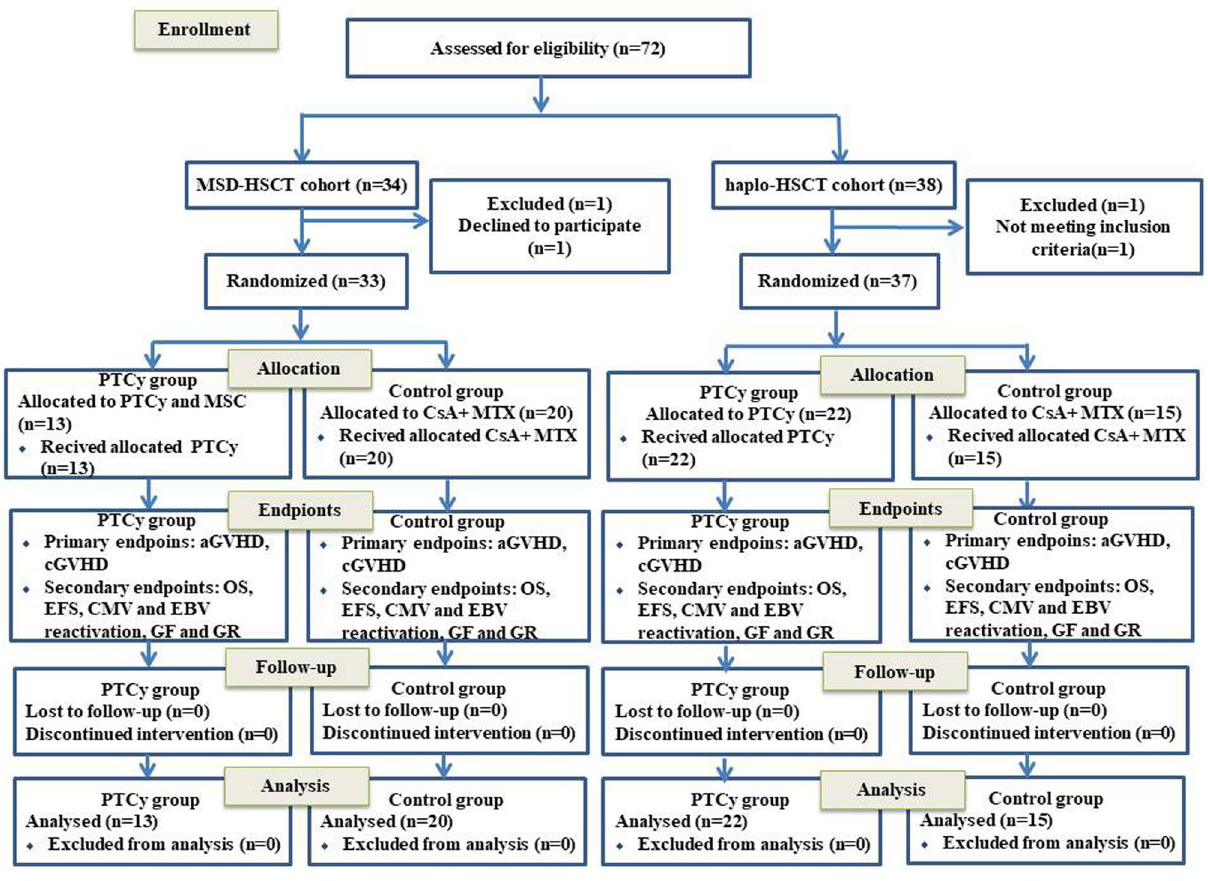
Figure 1. The flow diagram to describe the clinical course of